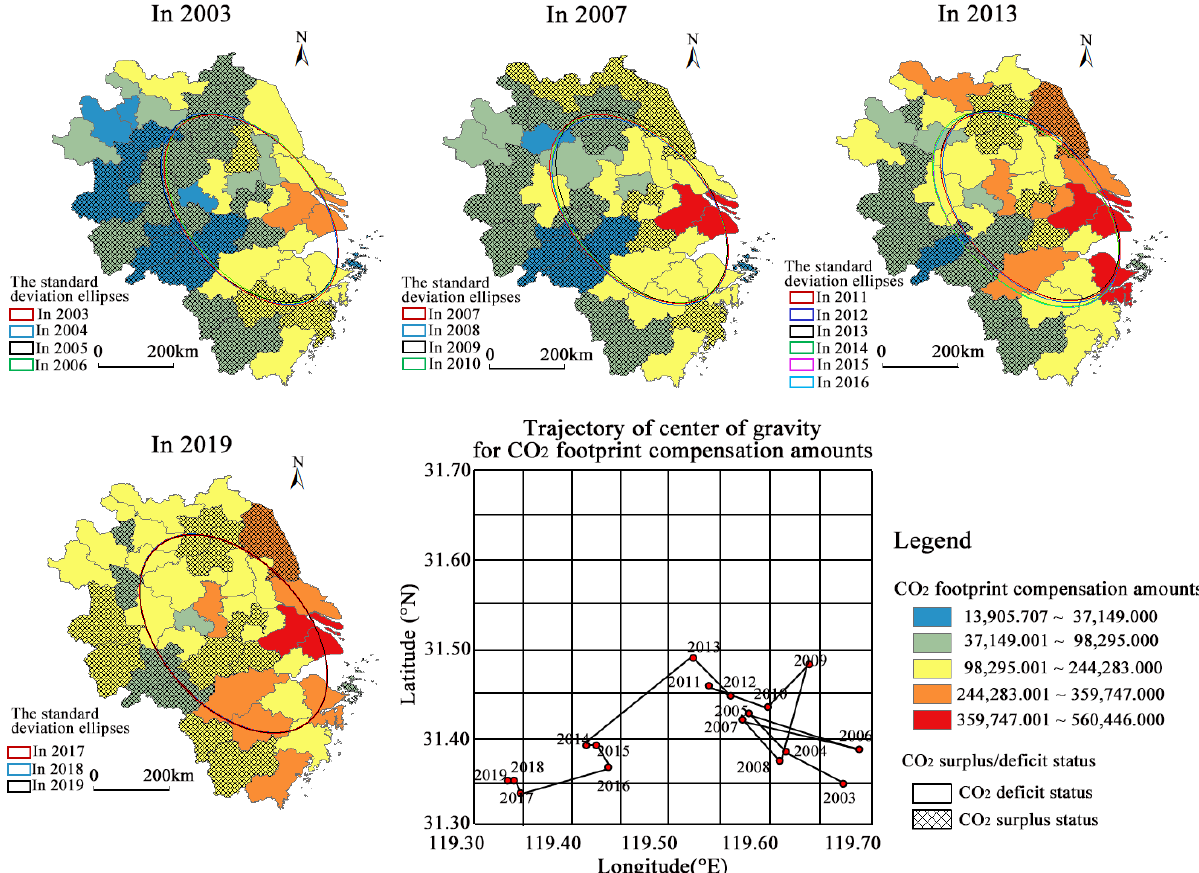
10.Figure 9. Evolution of CO 2 surplus and deficit and CO 2 footprint compensation amounts in the